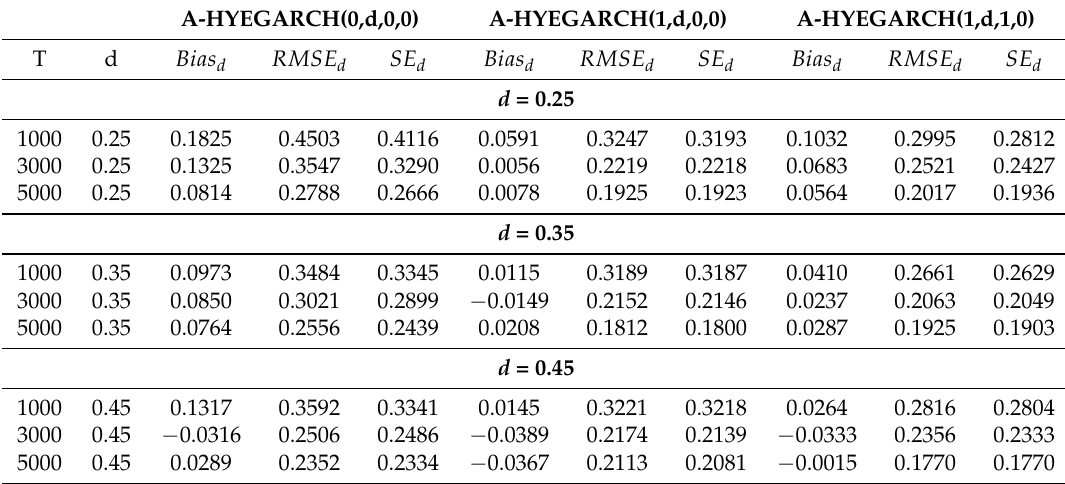
Table 1. Simulation results for estimation of A-HYEGARCH models without structural